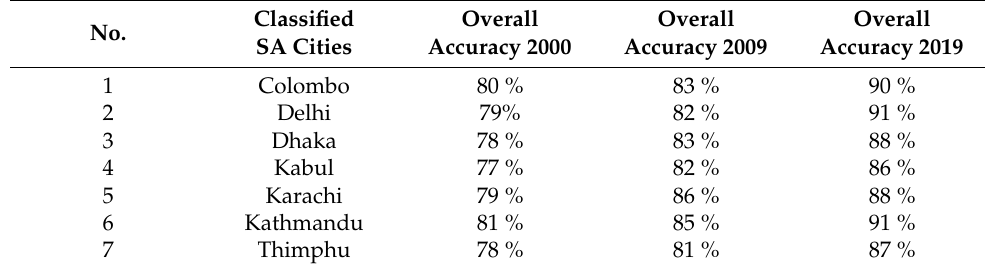
Overall Overall Overall Accuracy 2000 Accuracy 2009 Accuracy 2019